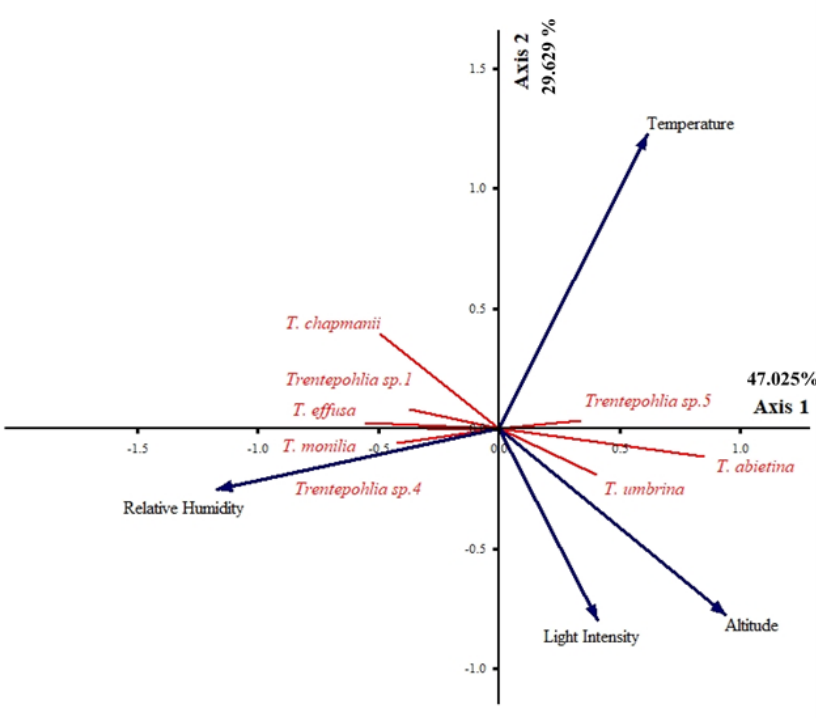
Figure 10 PCA ordination summarizing of the influence of environmental factors on communities of subaerialgreen algae genus Trentepohlia . Axis 1 represents 47.025% and Axis 2 represents 29.629% of the observed